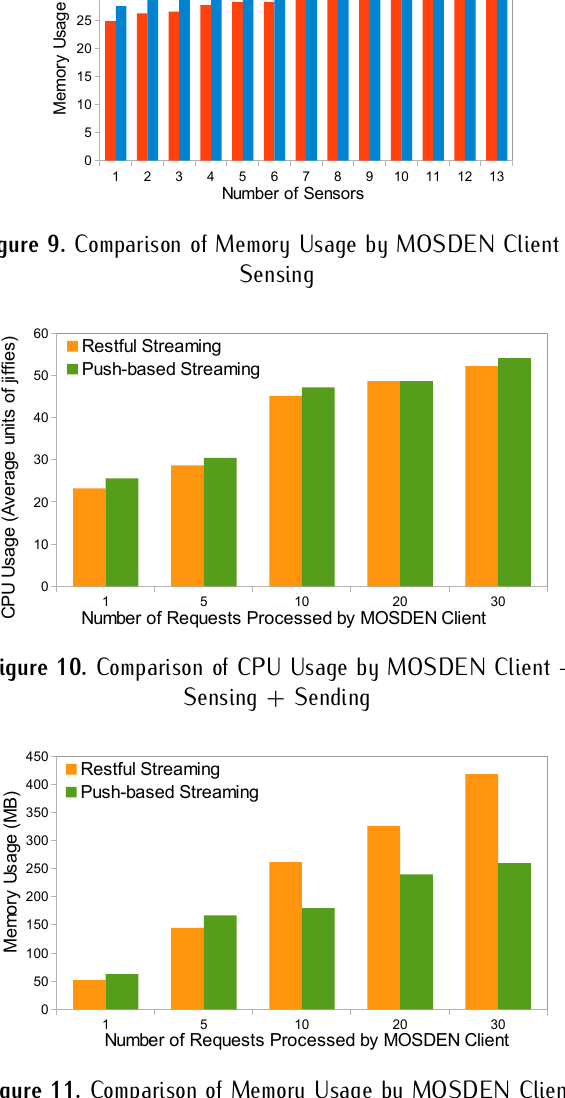
Figure 11. Comparison of Memory Usage by MOSDEN Client - Sensing +